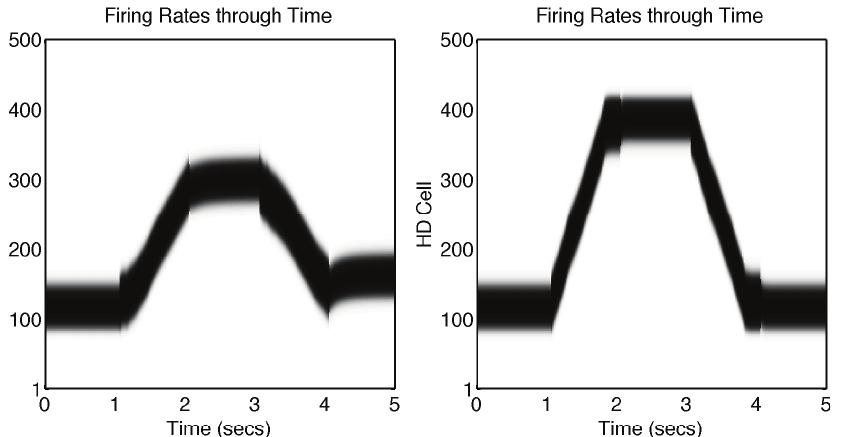
Figure 9. Firing rates of Head Direction (HD) cells during testing. These results are from simulations with an axonal conduction delay of 50 ms, and rotational velocities during training of 180 0 = sec (Left plot), and 360 0 = sec (Right plot). Conventions are as for the top-right plots in Figures 7 and 8.